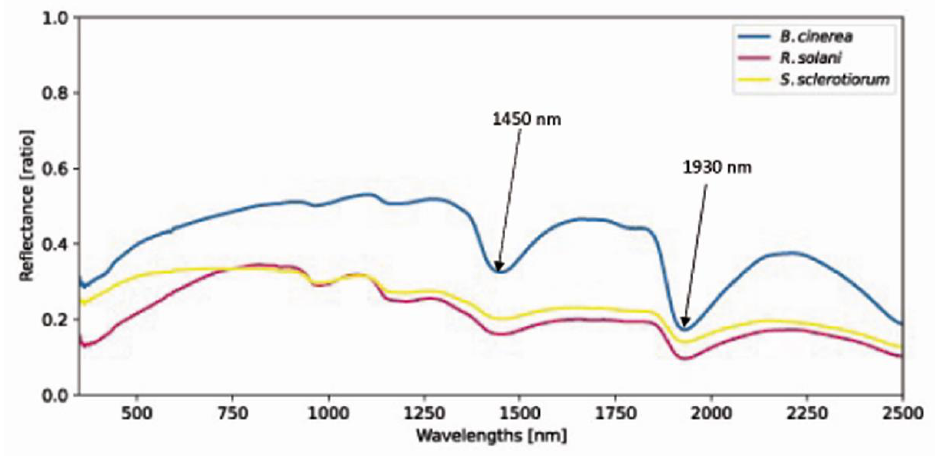
Figure 3. Mean spectra of three fungi species: B. cinerea , R. solani , S. sclerotiorum. The comparison of the spectral characteristics of the three species is presented in Figure 4. The highest differences in the whole optical range appeared between the spectra of B. cinerea and R. solani . Similar differences were observed between B. cinerea and S. sclerotiorum spectra, except for the VIS range and the second water absorption band in SWIR wavelength region. On the other hand, the minor differences were registered between R. solani and S. sclerotiorum . In this case, the highest differences were observed in the VIS spectrum. In the visible range, the reflectance of B. cinerea and R. solani showed a marked increase with increasing wavelength, while the reflectance of S. sclerotiorum was only recorded in the blue